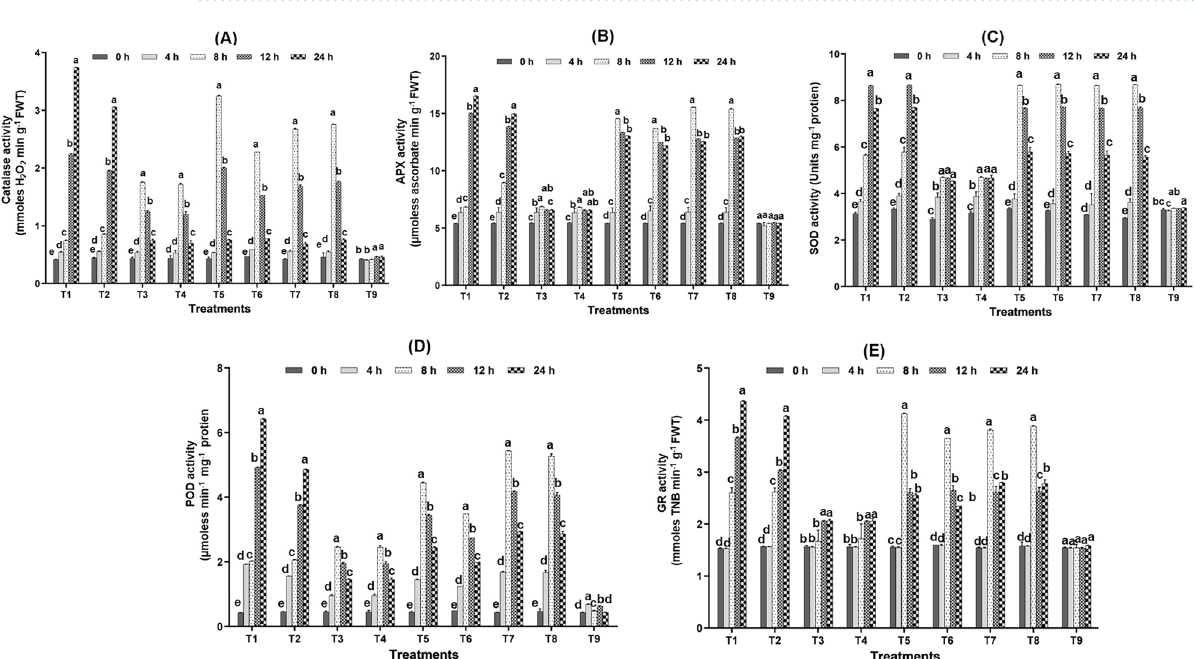
Figure 5. Effect of fungicides and seaweed biostimulants on activity of ( A ) CAT ( B ) APX ( C ) SOD ( D ) POD and ( E ) GR